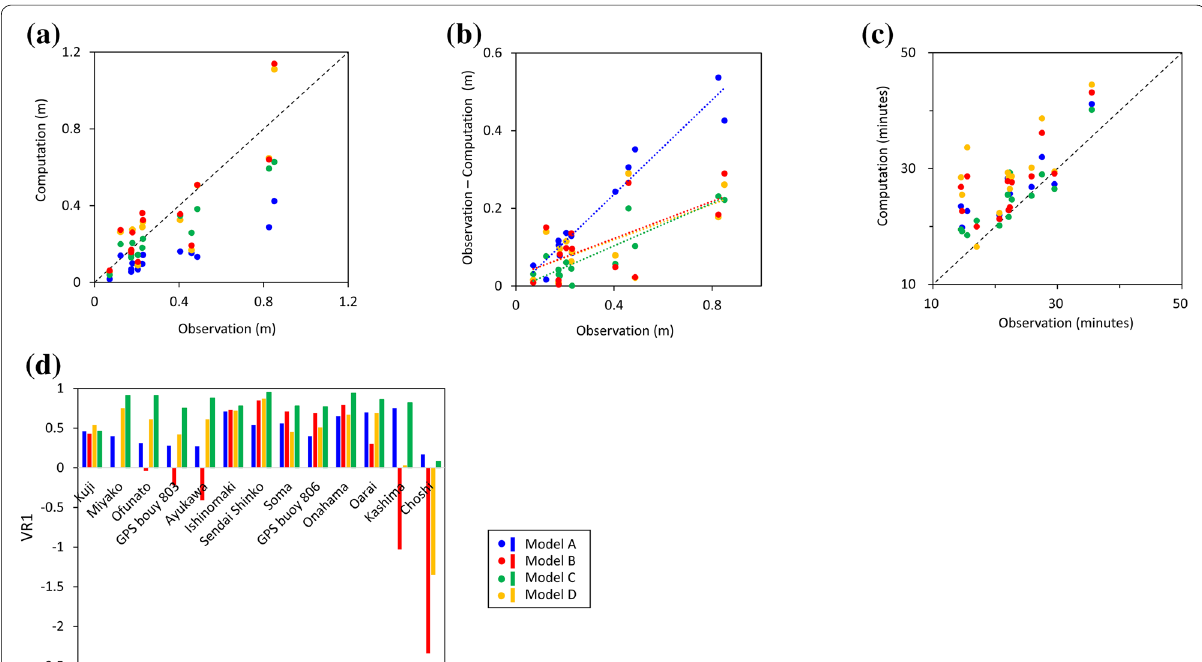
Fig. 5 Comparison of models A, B, C, and D at 13 stations. a Absolute amplitudes of the first pulling tsunami wave cycle. b Difference between the absolute amplitude of the computation and that of the observation. c Periods of the first wave cycle. d VR1. The dotted lines in b represent approximate best-fit